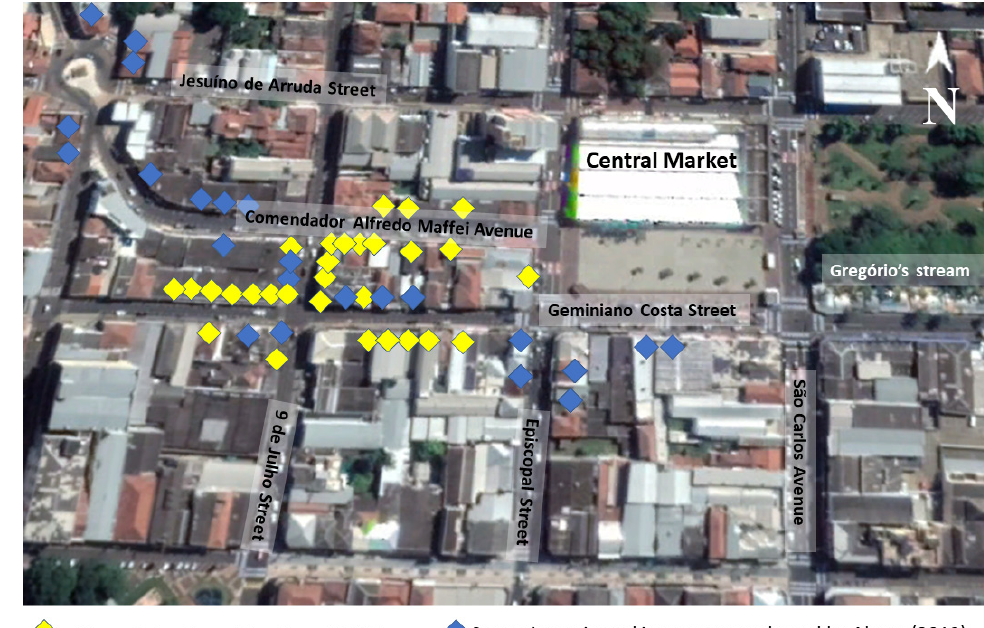
Figure 2. The 52 stores interviewed by Abreu [25].